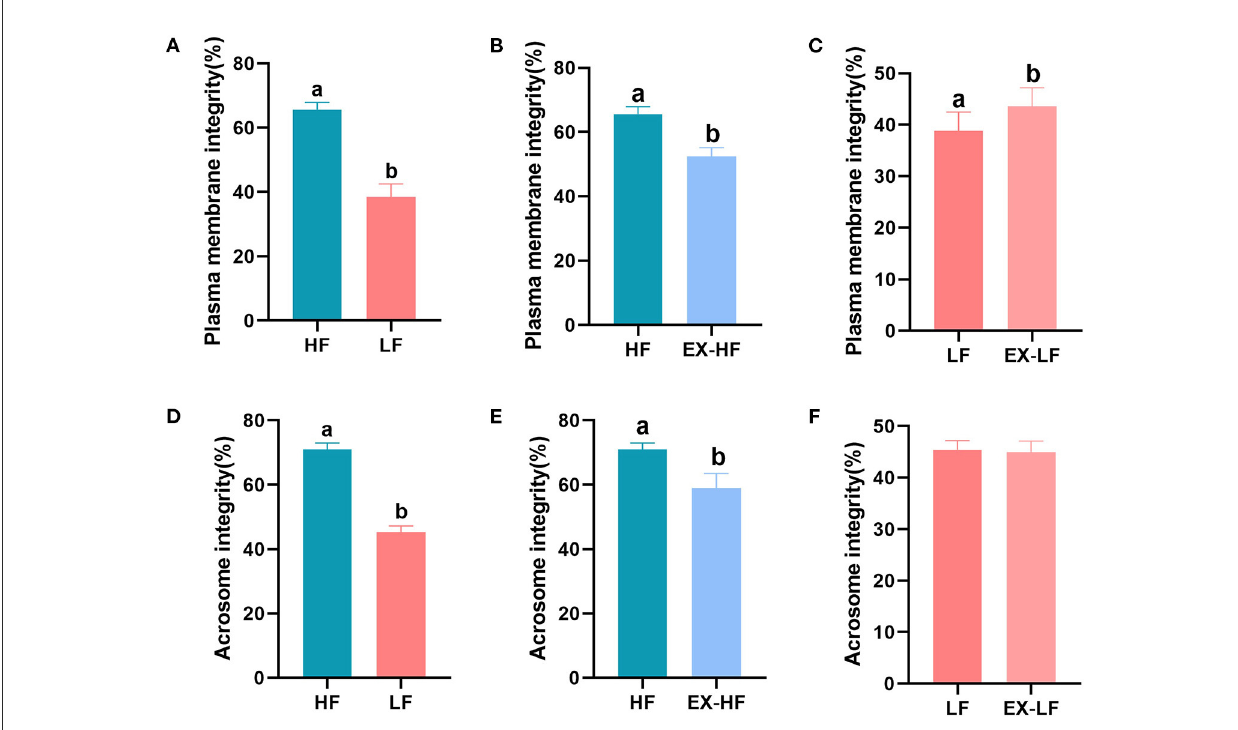
FIGURE2 Percentage of sperm plasma membrane and acrosome integrity for goats with high and low freezing resilience. (A–C) Plasma membrane integrity for HF vs. LF, HF vs. EX-HF, and LF vs. EX-LF and (D–F) acrosome integrity for HF vs. LF, HF vs. EX-HF, and LF vs. EX-LF.